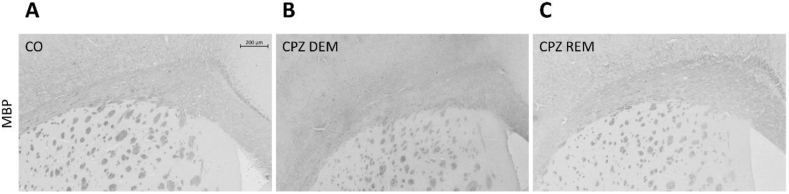
Myelin content determination of the corpus callosum with MBP staining in the CO (A), DEM (B) and REM (C) group, where the CPZ demyelination group (B) showed less myelin content, which increased in the remyelination phase (C). Scale bar: 200 μm. CO control group, CPZ cuprizone treated group, DEM demyelination phase of the treated group, MBP myelin basic protein, REM remyelination phase of the treated group.